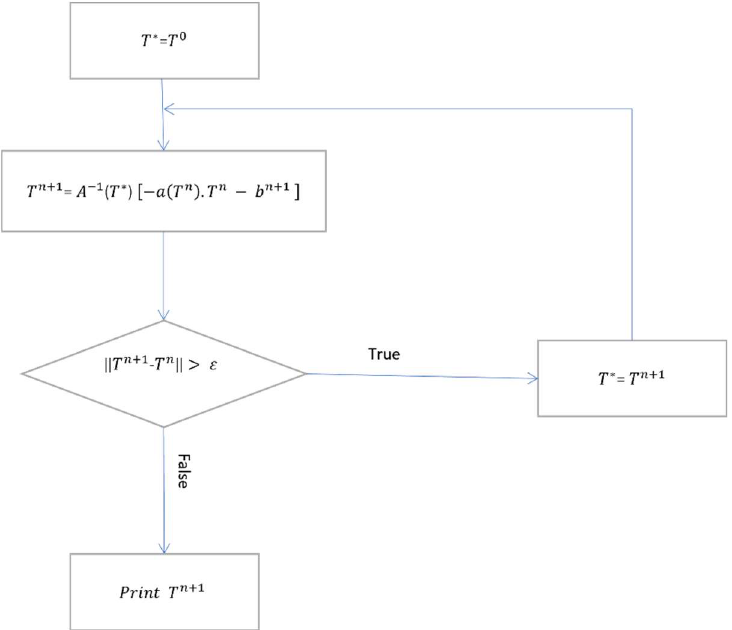
Figure 1. Algorithm for solving the problem at each time step.